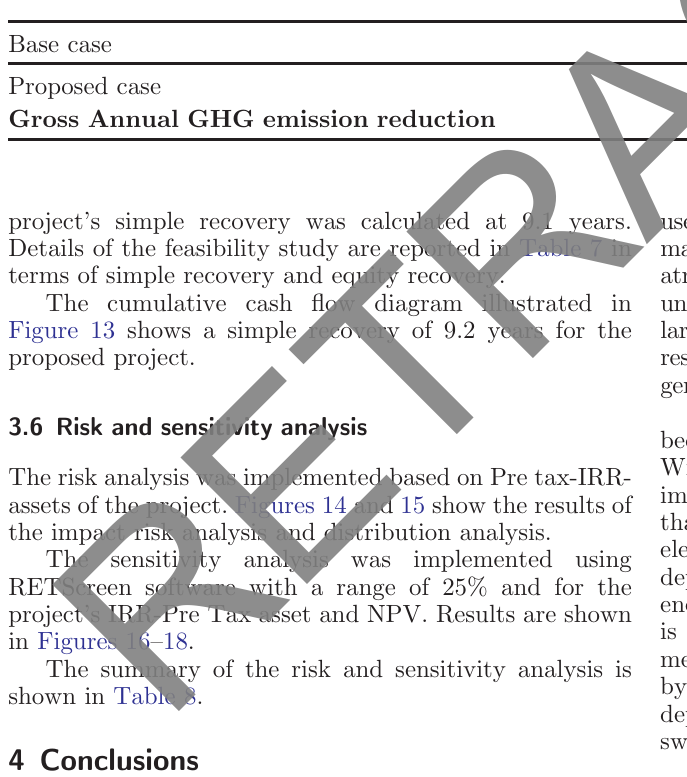
Table 6. GHG emission